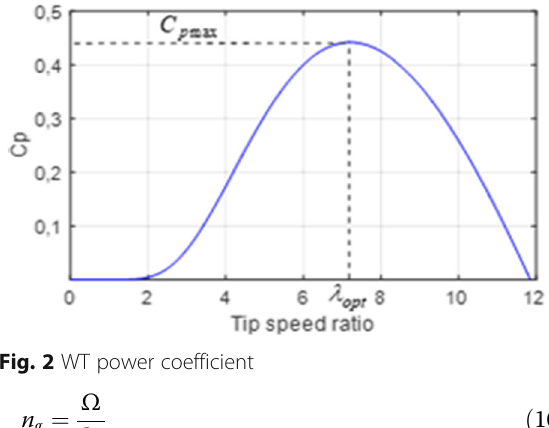
Fig. 2 WT power coefficient